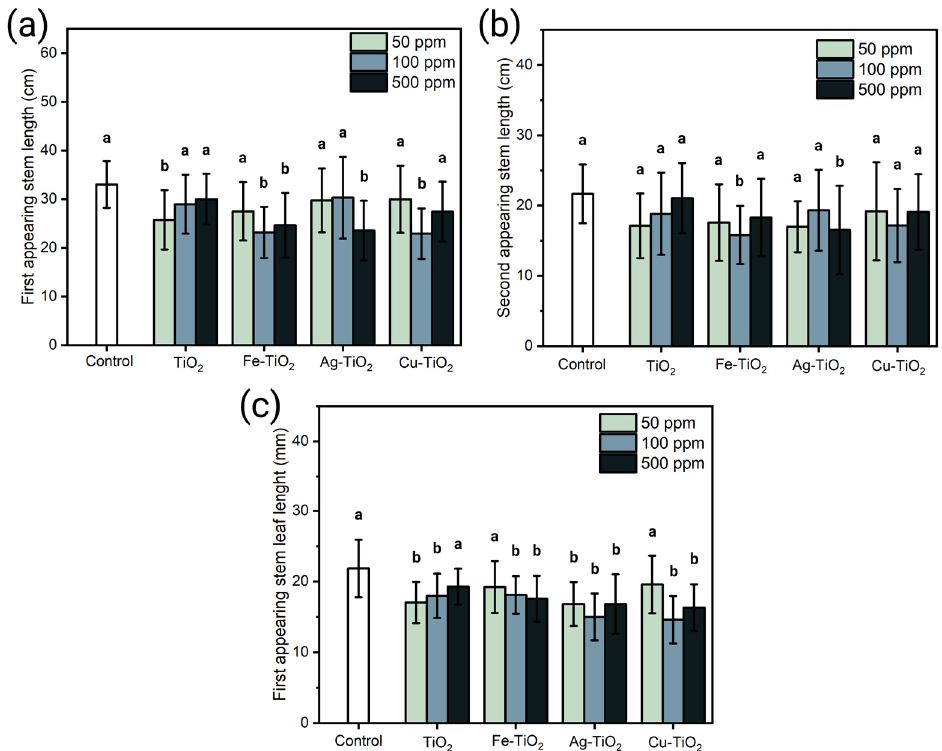
Figure 6. ( a ) Central stem length and ( b ) secondary stem length ( c ) leaf length of plants treated with Mw-SG-synthesized NMs for 80 days. Comparison between means was analyzed using a Dunnett assay with a p ≤ 0.05; means sharing a letter are considered not statistically different.